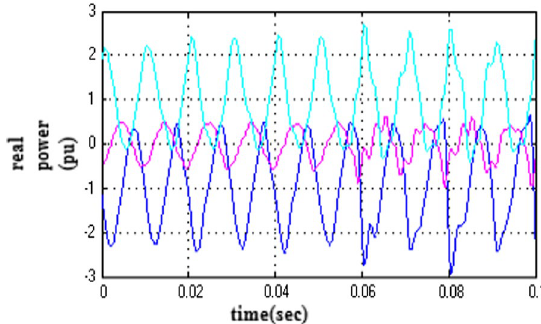
Fig. 10 Real power flow between buses 9 and 10 without TCSC for IEEE 57 bus system